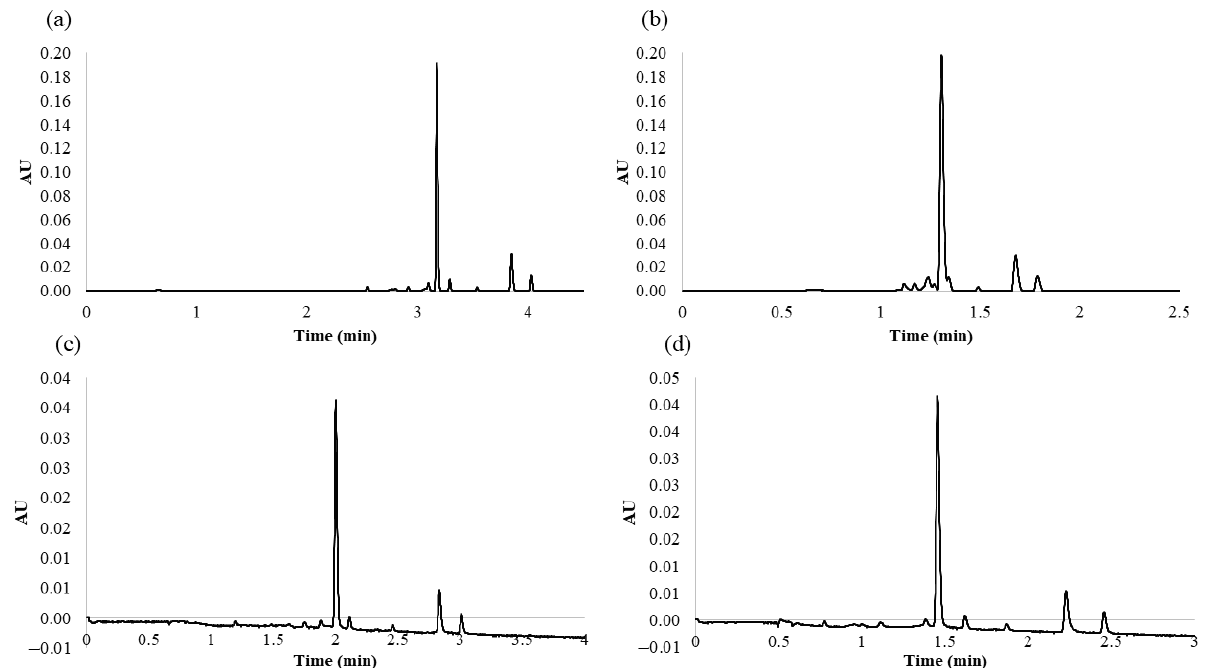
Figure 2. Different chromatograms obtained under different conditions: ( a ) chromatogram obtained from the 2° Box– Behnken design (BBD) experiment (analysis time longer than the established optimal conditions); ( b ) chromatogram obtained from the 11° BBD experiment (overlapping peaks); ( c ) chromatogram obtained at the lowest temperature, 35 °C (analysis times longer than the established optimal conditions); ( d ) chromatogram obtained at the highest temperature, 65 °C (poorer resolution than under the established optimal conditions).